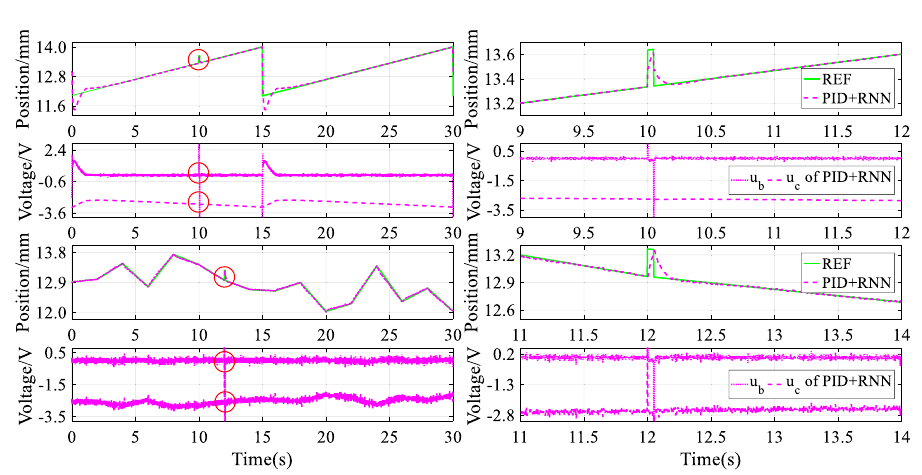
Figure 15. Experiment results of disturbance suppression under sawtooth and stochastic